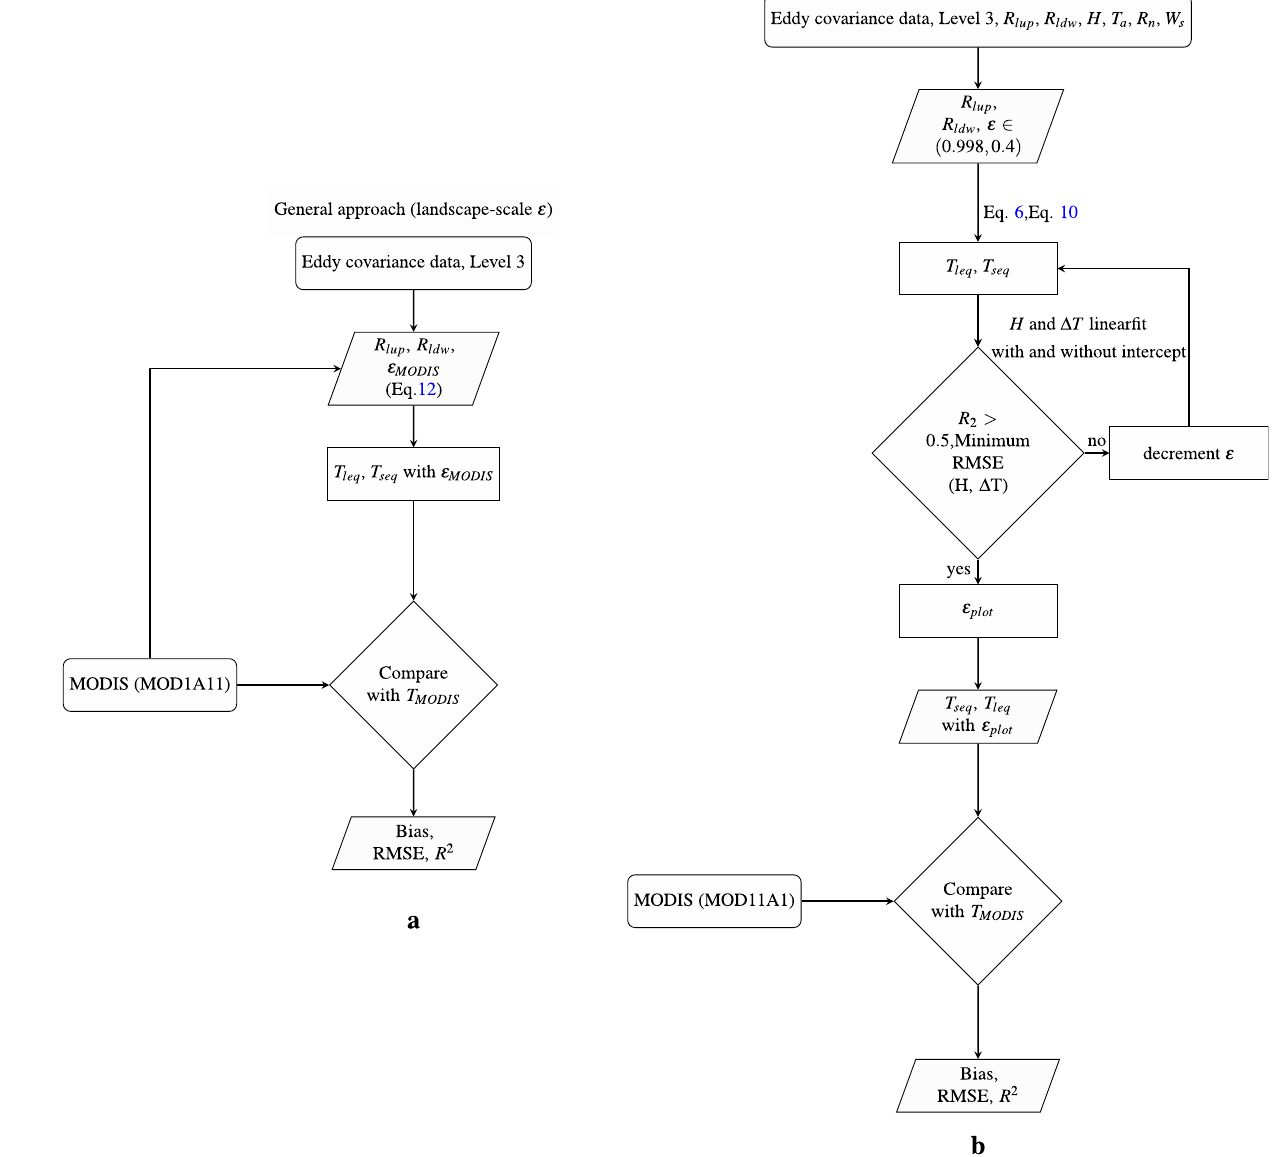
Figure 7. Schematic representation of steps followed for plot-scale LST retrieval using landscape-scale emissivity ( a ) or plot-scale emissivity ( b ). To estimate plot-scale ε plot , surface-air temperature difference ( (cid:31) T ) is computed from observed longwave radiation ( R lup and R ldwn ) and T a for given ε plot , and then ε plot is varied in a way to minimise RMSE of a linear relationship between observed sensible heat flux (H) and (cid:31) T . The resulting 2 surface temperatures ( T leq , T seq ) are then compared to T MODIS , with the R , RMSE, and bias reported in Fig. with a high value of intercept (HS and LF in Table 1) we tested if adding 6–8% to the observed R lup and closing the energy balance using Bowen ratio closure before ε plot estimation would remove the intercept (Fig. 5). Recently, another approach for plot-scale ε estimation using Eq. (4) was used by Maes et al. 11 . In this approach, data sets are filtered for non rainy days without snow cover ( α < 0.4 ) and near-zero H ( − 2 < H < 2 ). The ε values are then estimated by substituting T s = T a in Eq. (4) as shown in Eq. (11). The monthly ε was obtained as the median of ε obtained by substituting filtered data in Eq. (11) (red stars in Fig. 1).